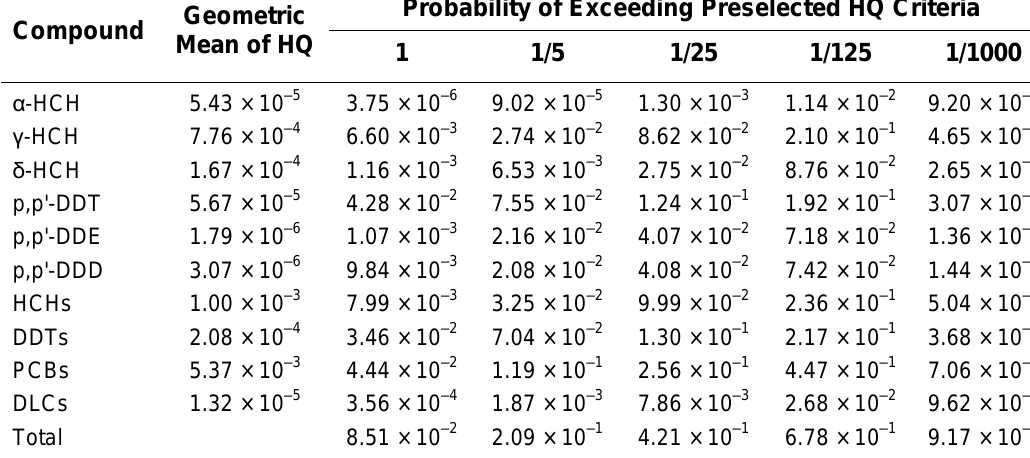
The Results from the Monte Carlo – Based HQ Distribution Method